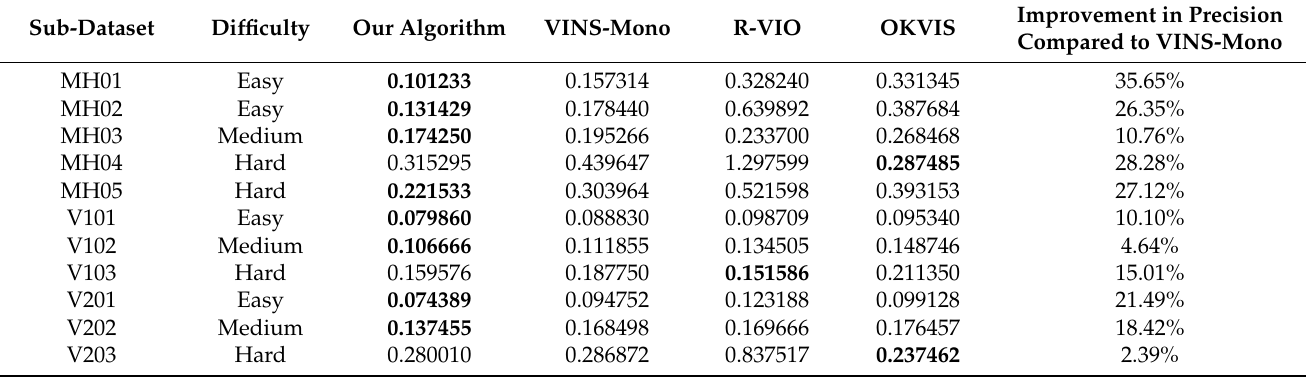
Table 2. Comparison between the proposed algorithm and several open-source frameworks in terms of APE. Bold indicates the excellent value of the results in the same